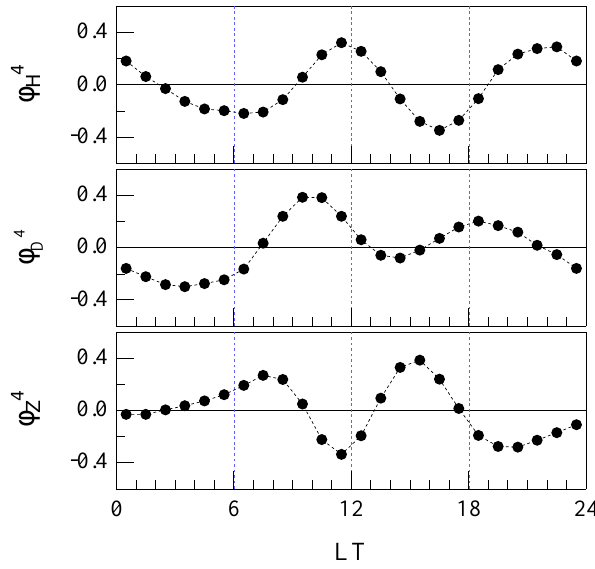
Fig. 10. The EOFs associated with the contribution to the daily variation due to other magnetospheric current systems and relative to H, D and Z magnetic field